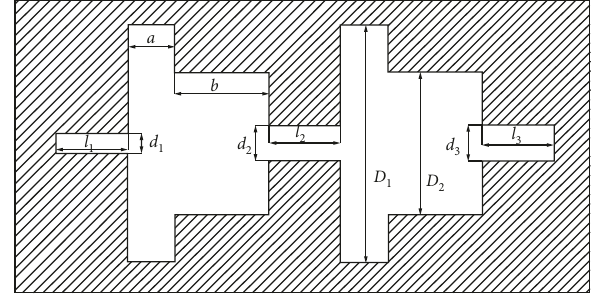
Figure 5: Diagram of the internal structure of the organ pipe +organ pipe cavitation